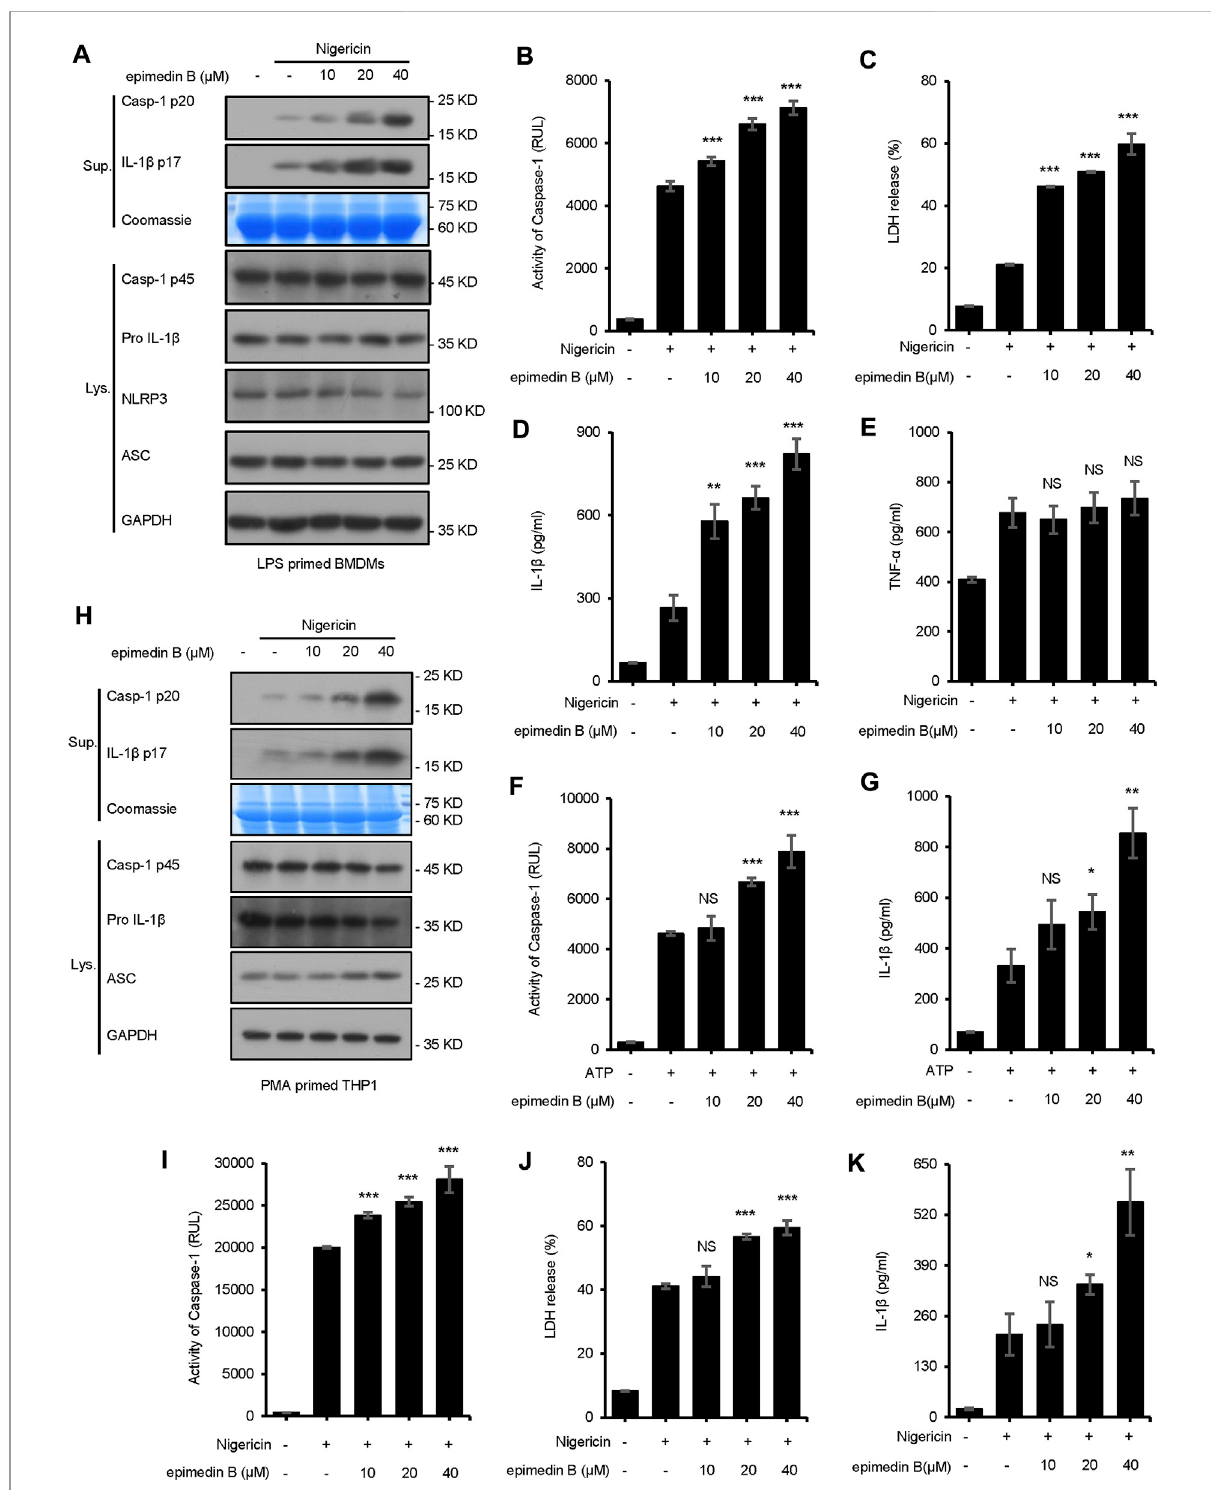
FIGURE 3 Epimedin B promotes NLRP3 in fl ammasome activation in bone marrow-derived macrophages and THP1 cells stimulated by nigericin or ATP. (A) Western blot analysis of supernatants (Sup) and whole-cell lysates (Lys) derived from lipopolysaccharide (LPS)-primed bone marrow-derived macrophages (BMDMs) subjected to treatment with various doses of epimedin B prior to nigericin stimulation. (B – E) Caspase-1 activity (B) , the release of lactate dehydrogenase (LDH) (C) , ELISA of IL-1 β (D) and TNF- α (E) levels in supernatants (Sup) from samples described in (A)